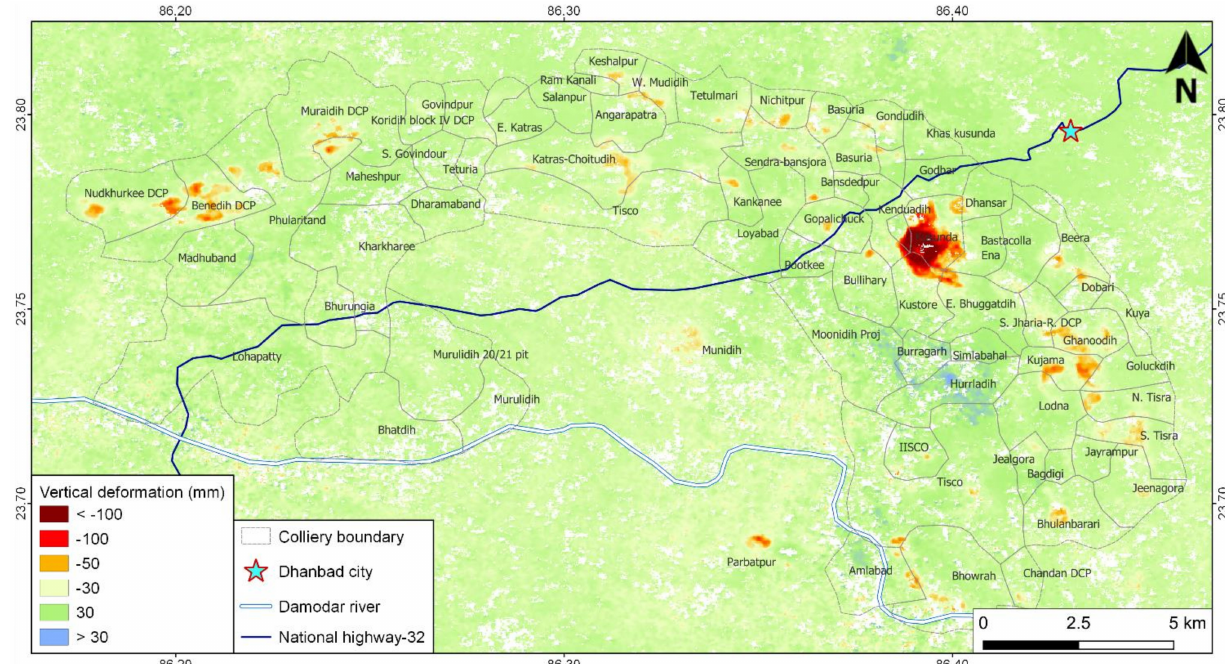
Figure 4. Vertical surface deformation cumulative over